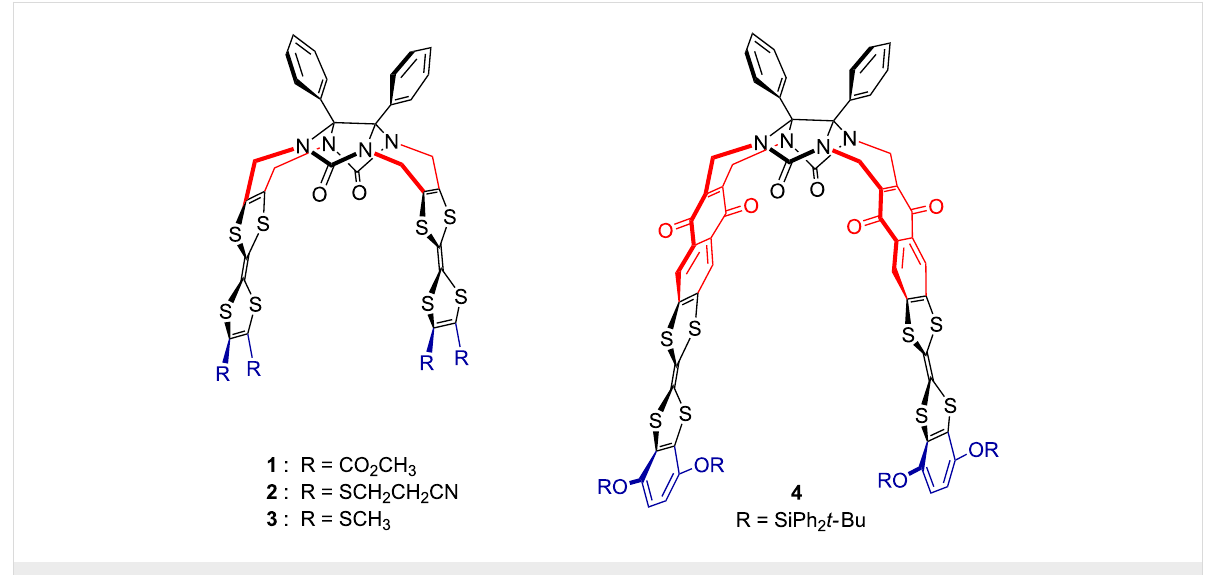
Figure 1: Structures of molecular clips 1–4